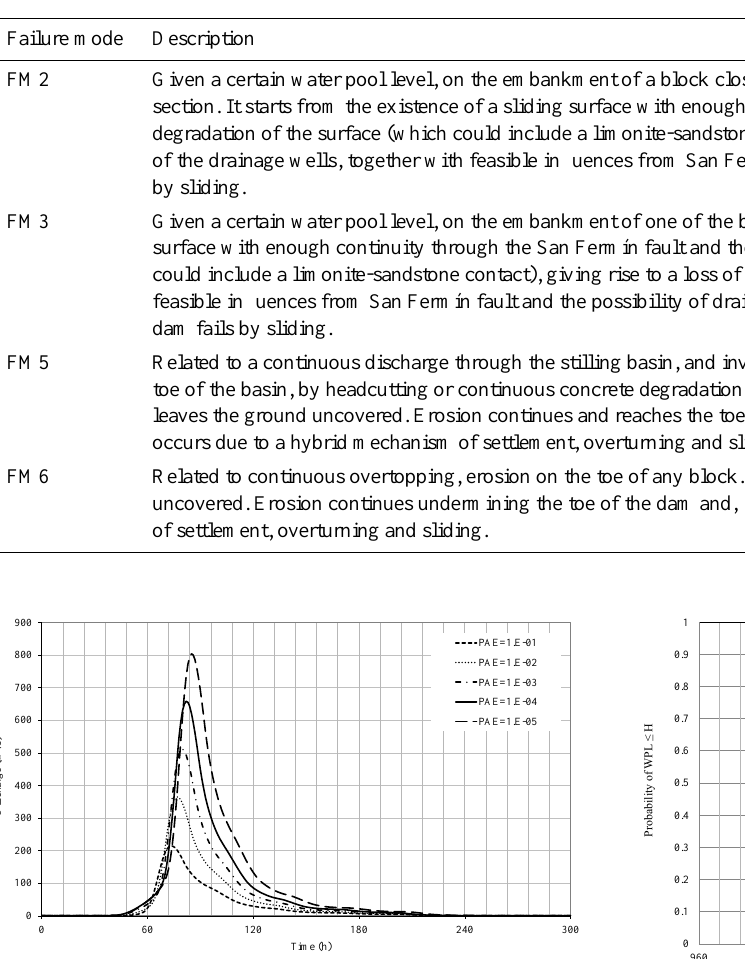
Table 8. Failure modes considered for the analysis.